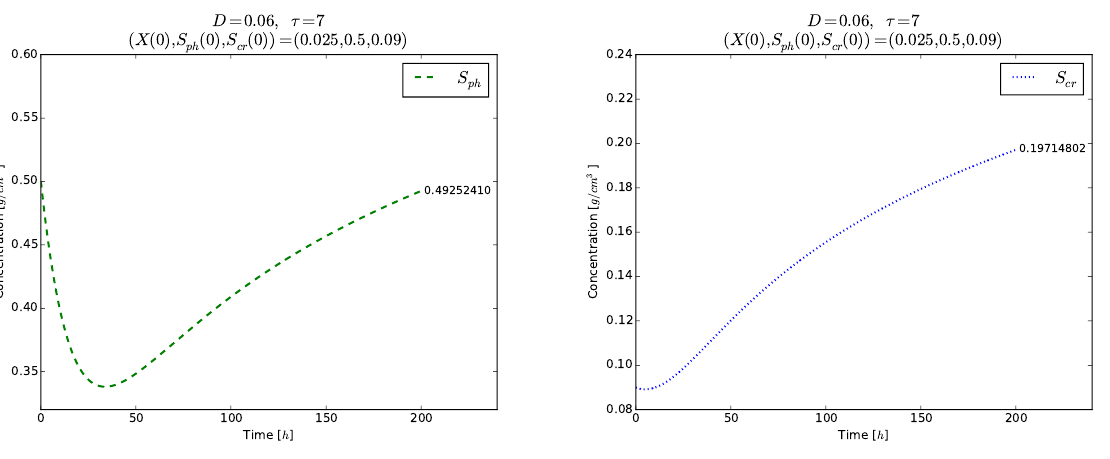
Figure 9. Example 3. Time evolution of S ph ( t ) ( left ) and S cr ( t ) for t ∈ [ 0,200 ] ( right